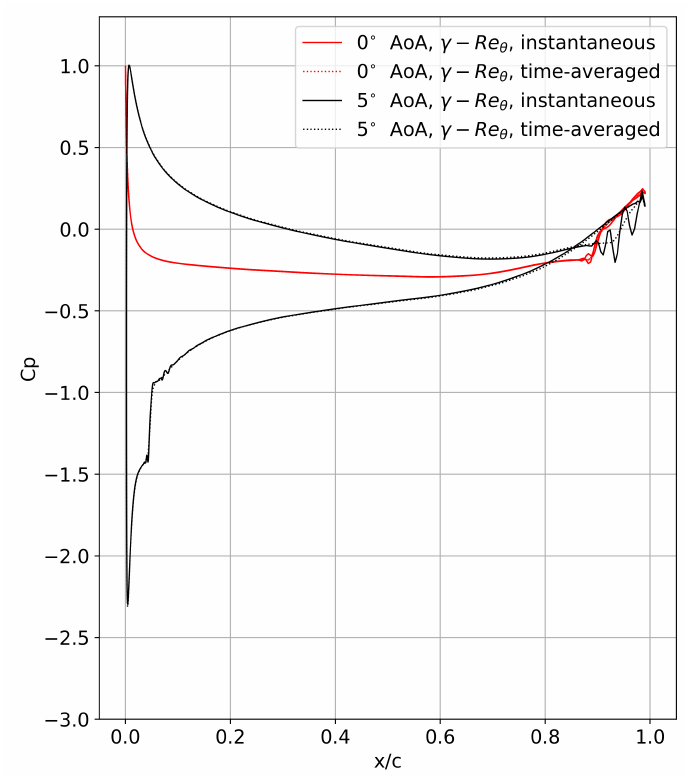
Figure 8. Predicted pressure coefficients at AoA of 0 ◦ and 5 ◦ , Re =